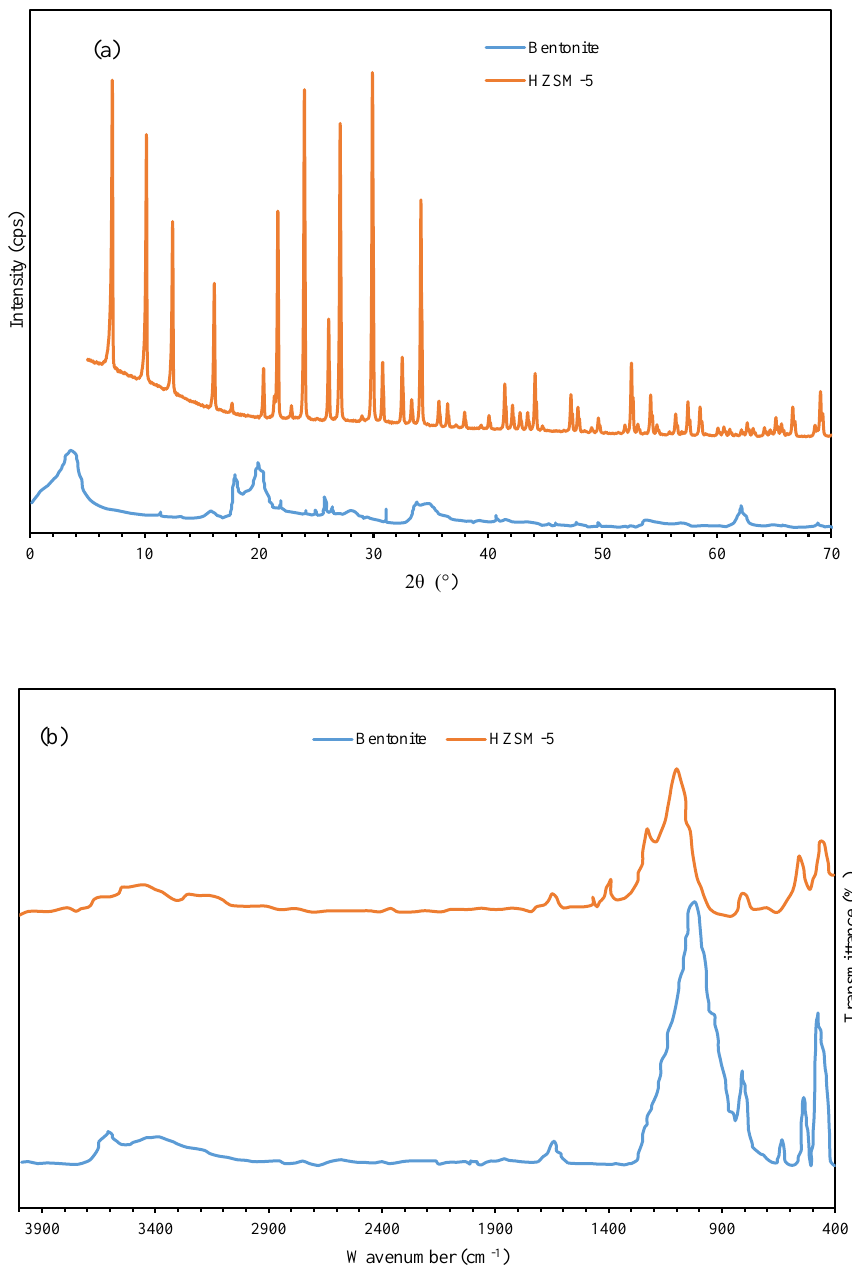
Figure 2. XRD ( a ) and FTIR ( b ) pattern of bentonite and HZSM-5. For the HZSM-5 zeolite, the 1225 cm − 1 and 799 cm − 1 bands represent the external T- O-T asymmetric stretching and symmetric stretching, while 1098 cm − 1 is the internal T-O-T asymmetric stretching. The 559 cm − 1 and 450 cm − 1 are the vibration absorption peak of the five-membered oxygen ring in the framework and the T-O-T bending vibration (T could be Si or Al). Moreover, the broad peaks at 3452 cm − 1 and 1647 cm − 1 represent the OH group stretching and bending vibration of physically absorbed water on the HZSM-5